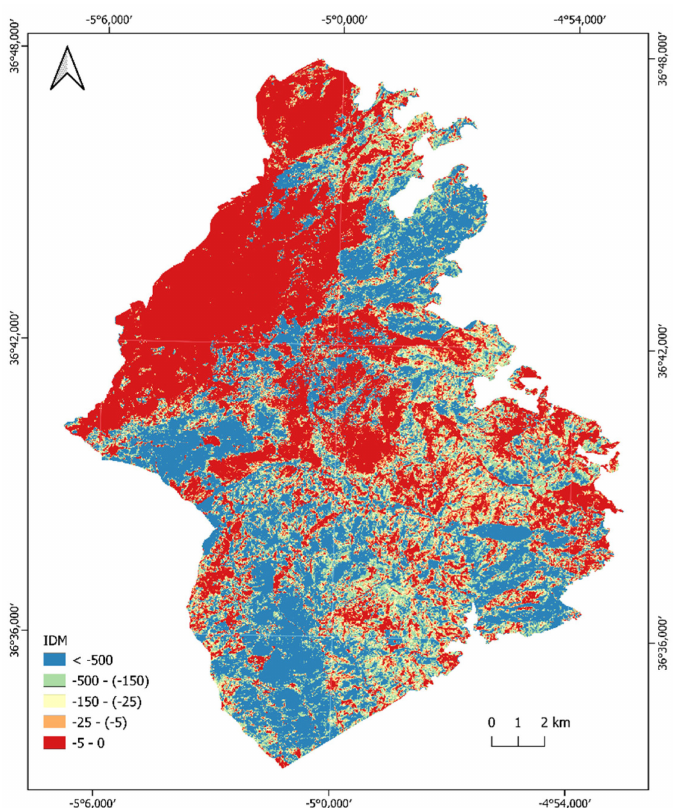
Figure 6. Fuel Desiccation Index (IDM) of forest types in Sierra de las Nieves National Park (M á laga, southern Spain).